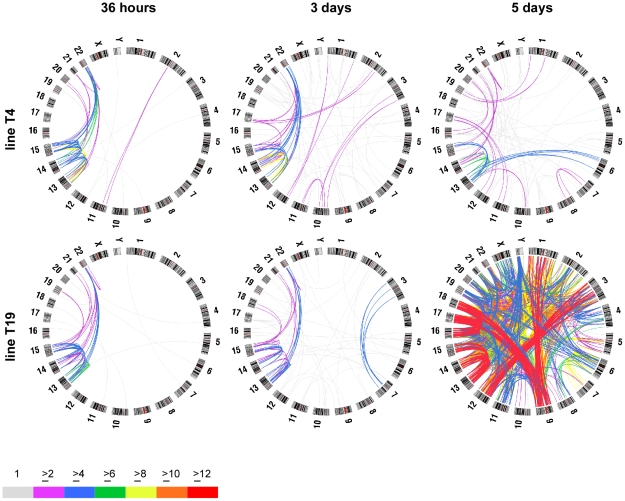
Circular maps illustrating chromosome fusions that occur after short- and long-term expression of dnTRF2.FISH was used to determine the frequency of specific chromosome fusions. Over 1000 fusions were scored in these analyses (≥25 metaphase/timepoint/cell line). Circle plots were generated using Circos (http://mkweb.bcgsc.ca/circos/) to visualize chromosome fusions over time after dnTRF2 expression. Chromosomes are shown along the outside of the circles. The lines are intended to represent fusions between specific chromosomes but do not designate precise breakpoints; line colors represent numbers of fusions (see color key). Acrocentric chromosome fusions represented the major fraction of dicentrics in short inductions of subclones T4 (top row) and T19 (bottom row). At 36 hours, most fusions occurred between acrocentrics. After 3- or 5-day dnTRF2 inductions, the percentage of non-acrocentric fusions increased. This is evident in the 5-day induction of T19 in which acrocentric interactions predominate (red lines), but HSA1-HSA9, HSA3-HSA12 and HSA9-HSA18 fusions also occurred frequently.